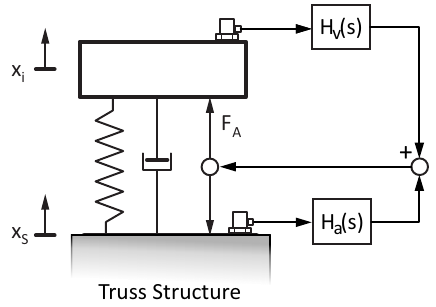
Figure 15. Block diagram of the control